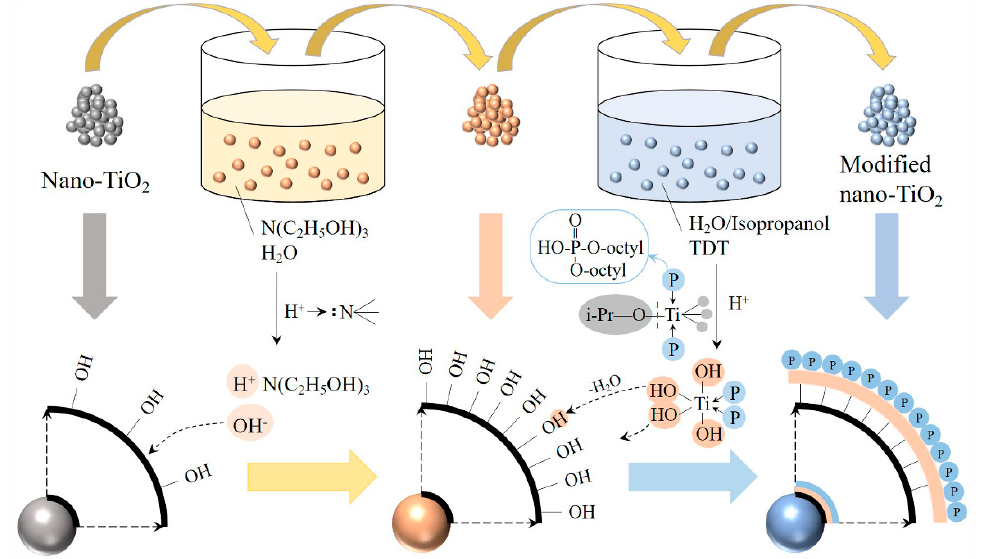
Figure 1. Procedure of preparing surface-modified nano-TiO 2 particles.